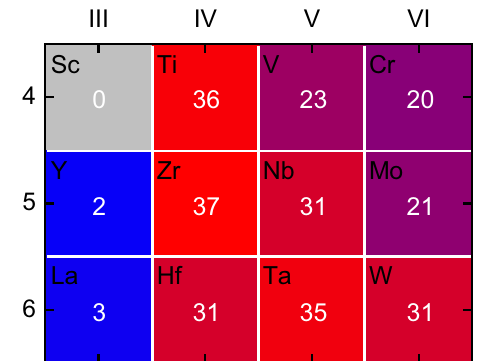
Fig. 9 Frequencies of different metallic elements appeared in the collected HECCs. Numbers in this fi gure denote elemental